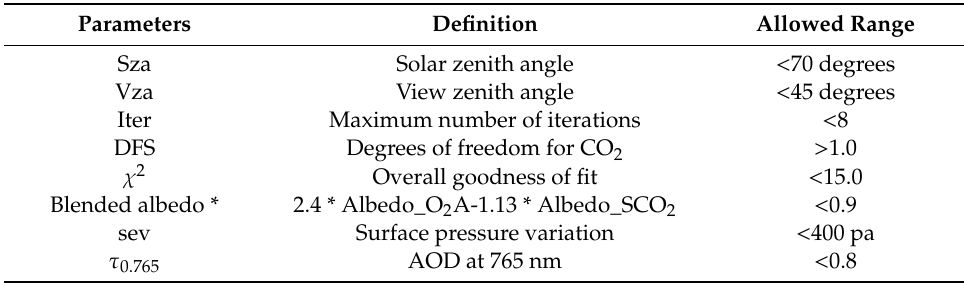
Table 2. Settings of the filters used for excluding low quality XCO 2 retrievals. Parameters Definition Allowed Range Sza Solar zenith angle < 70 degrees View zenith